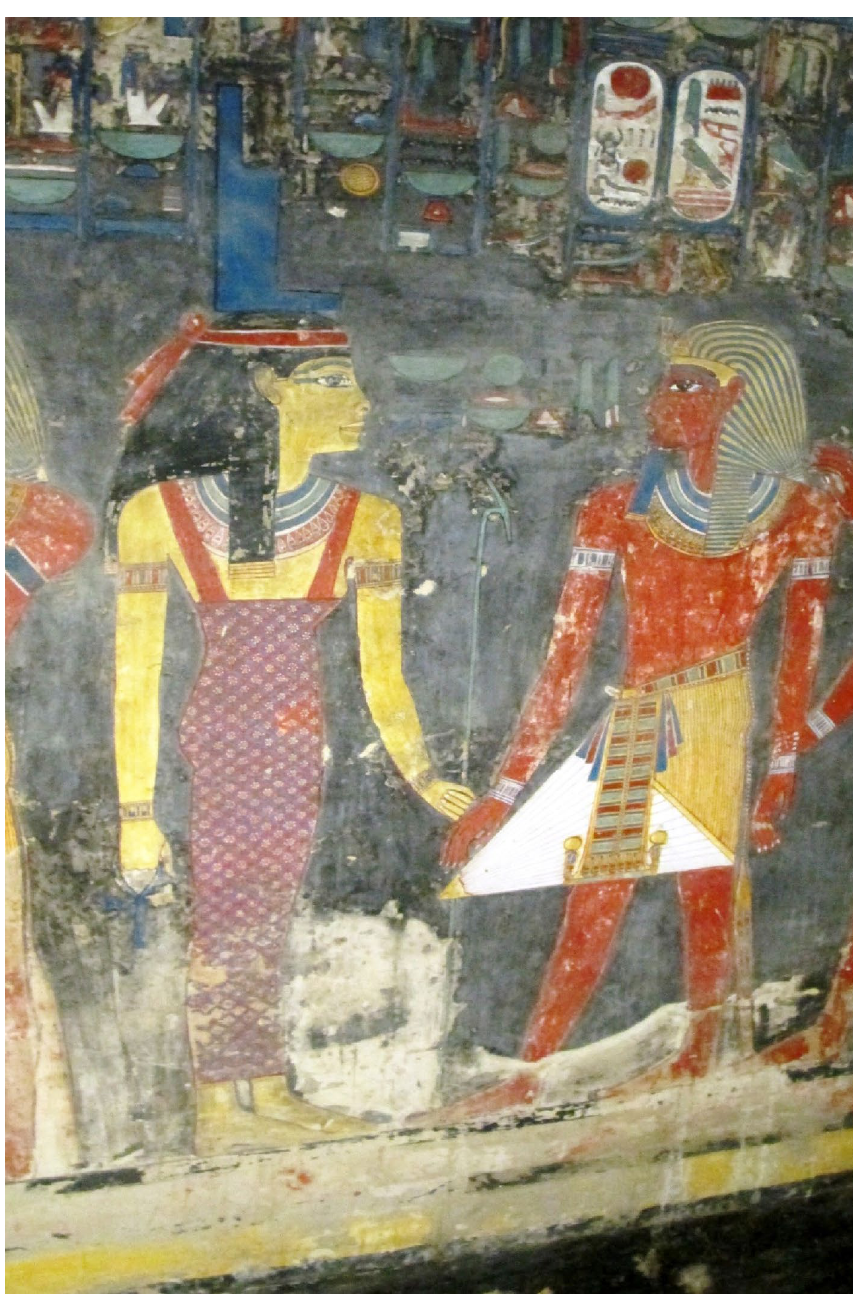
Fig. 2 Carved and decorated walls in massive Esna shale Member are in advanced state of disintegration. Showing chert lenses. The ornamented plaster on top of the chert lenses and nodules was damaged during the first flash floods that entered the tomb some 3000 years ago. During several restoration projects over the past 200 years, cracks were filled with plaster for protection and stabilization of the tomb. The impact of